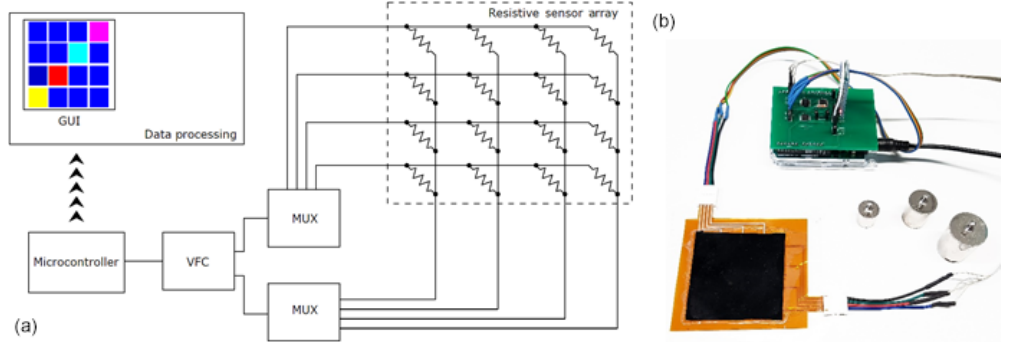
Figure 3. Schematic representation (a) and the sensor matrix with the hardware set-up (b) of the data acquisition system.